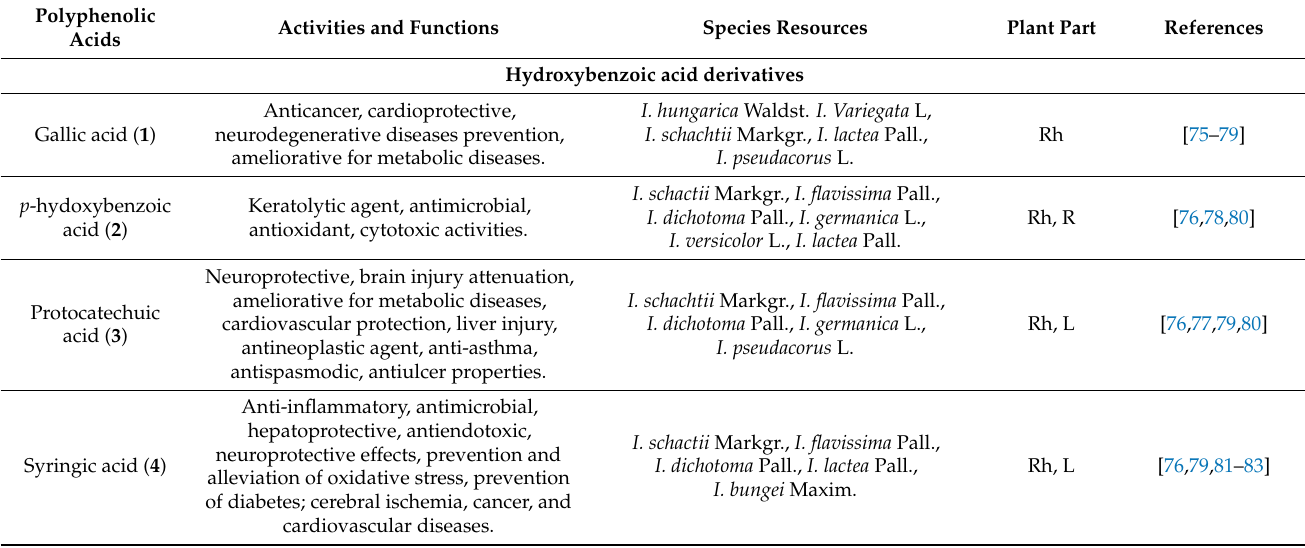
Table 3. Polyphenolic acids present in Iris species and their antioxidant related